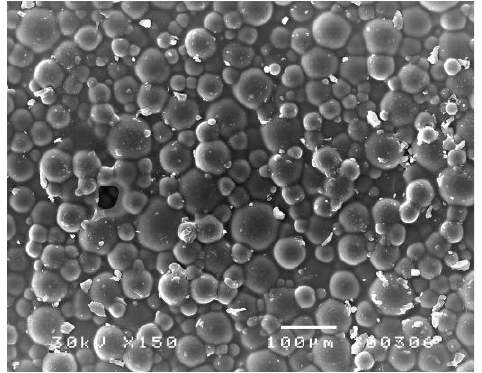
Figure 1. Fused granules of firm cold-polymerized acrylate samples, up to 100 µm in size. The material showed partial porosity [33].